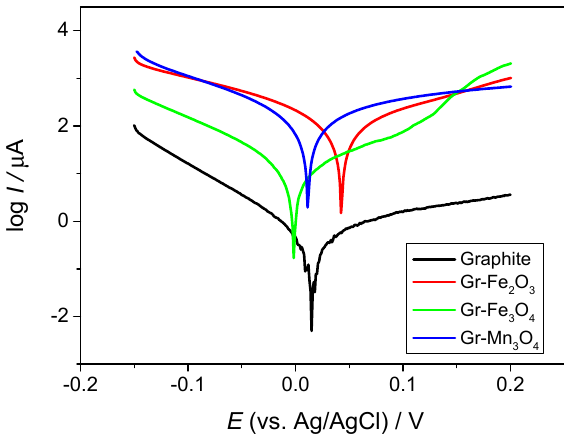
Figure 3. Tafel plots of the modified and non-modified graphite electrodes in 0.1 M PBS (pH 7).